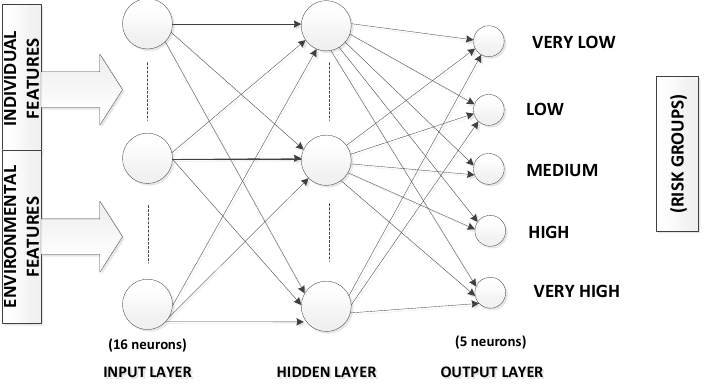
Figure 6. ANN structure for fire evacuation model.